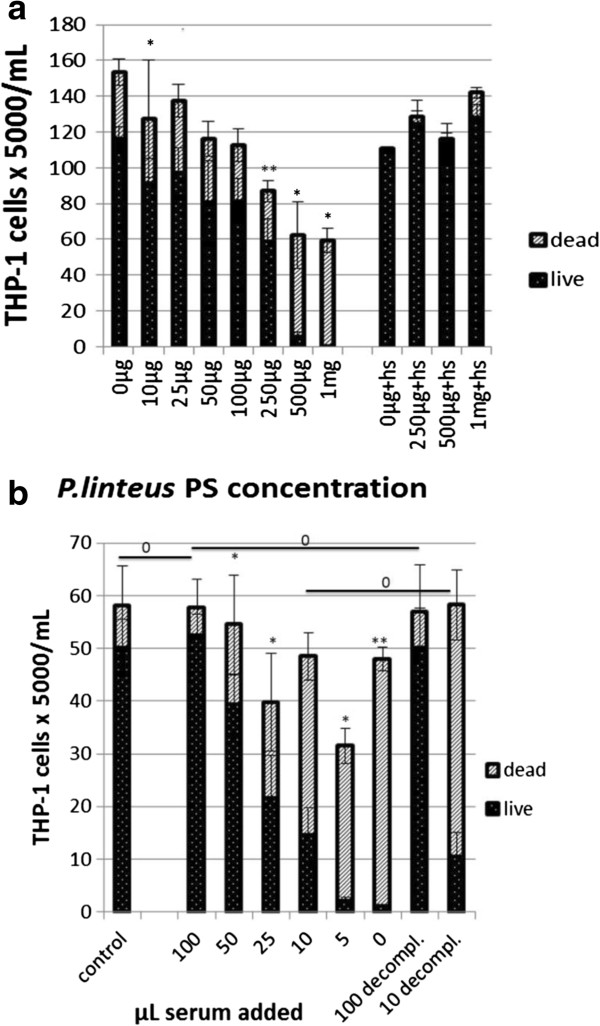
Protective effect of human serum against P. linteus polysaccharide extract induced cell death in THP-1 cells (b) compared with the effects of varying P. linteus polysaccharide extract concentrations (a). THP-1 cells were cultivated for 24 h in complete RPMI medium with 100 μg/mL P. linteus polysaccharide extract to which increasing amounts of human serum was added. Cells were stained with trypan blue and non-colored cells were considered "live". Blue cells were considered "dead". A minimum of 1000 cells was counted per point. Figure 
5a shows concentration-dependent cytotoxicity of P. linteus polysaccharide extract. In the right section of the figure the effect is shown of simultaneous addition of 100 μL of human serum. Figure 
5b shows the concentration-dependent inhibition of P. linteus polysaccharide extract cytotoxicity by human serum respectively by decomplemented serum. *P < 0.01, **P < 0.05, significantly different from the values of the previous (lower) concentration in the range; 0P > 0.05 not different between the concentrations indicated.